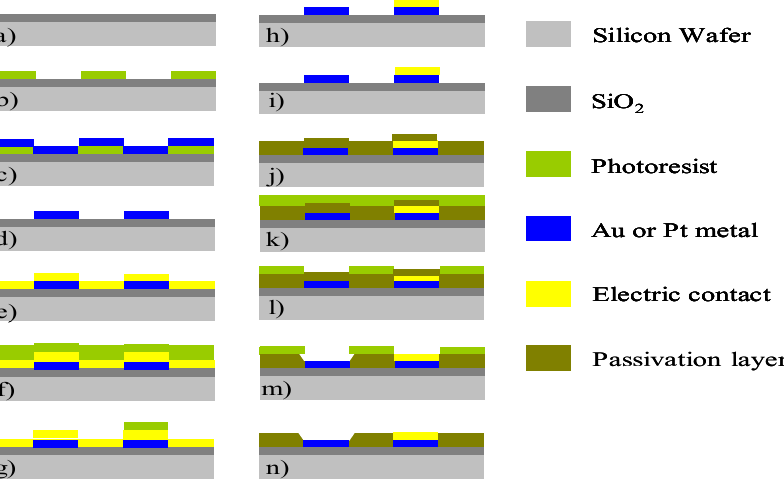
Figure 3. Fabrication process of a microelectrode using a standard photolithographic technique.